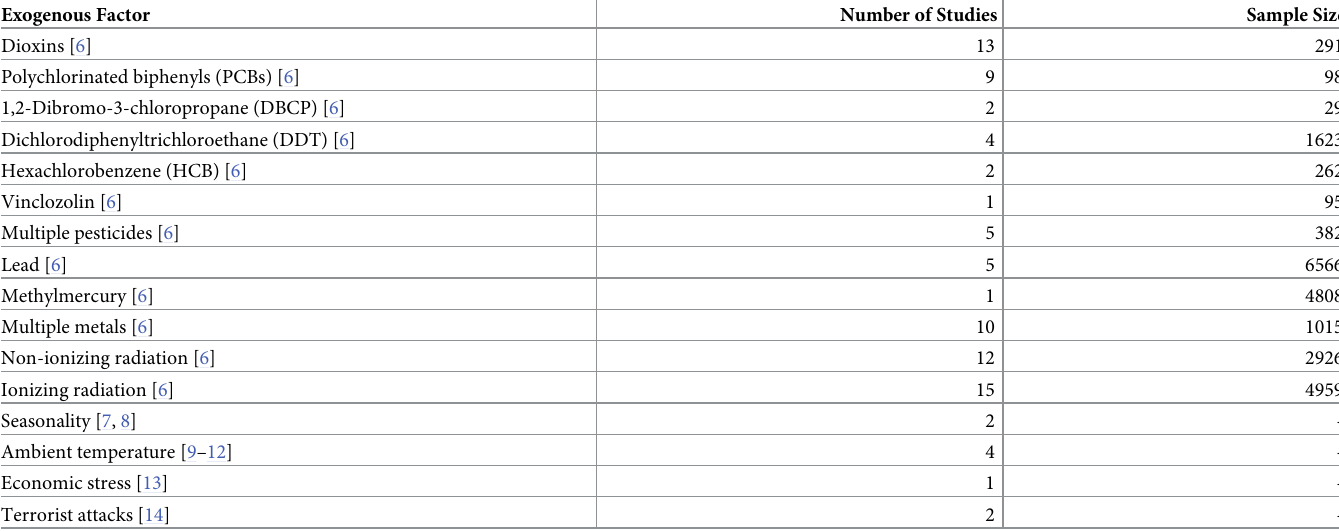
Table 1. Exogenous factors reported in the literature to have an impact on the SRB [6, 14]. A “-” indicates that sample sizes were not mentioned in the articles reporting or reviewing the corresponding